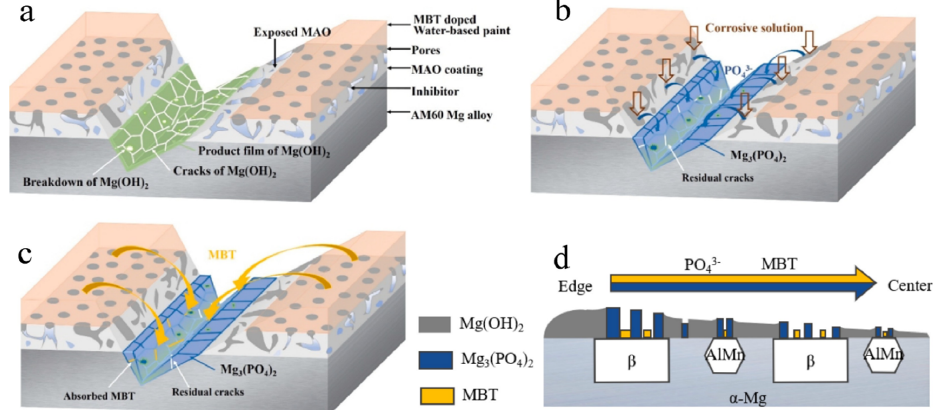
Figure 10. Schematic illustrations of the healing process of self-healing coating. Reprinted with permission from Ref. [83]. Copyright (2019) Elsevier.